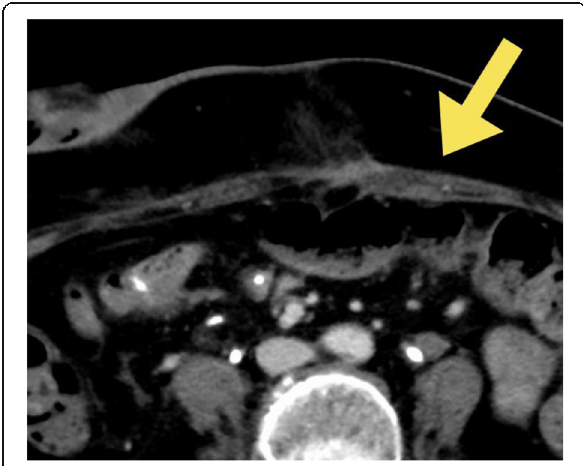
Fig. 1 Enhanced abdominal CT on POD 16. The figure shows an enlarged left rectus abdominis with inhomogeneous